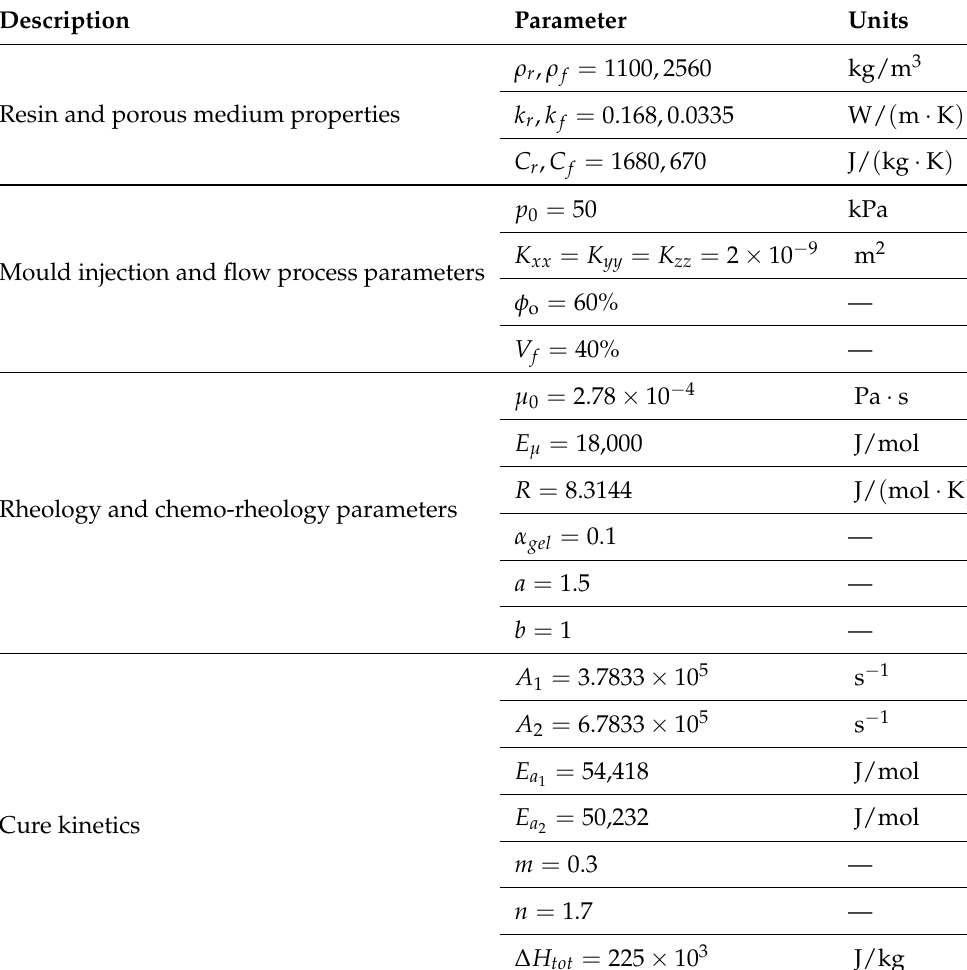
Figure 3. Part shape geometry and boundary conditions. Table 1. Material and process parameters